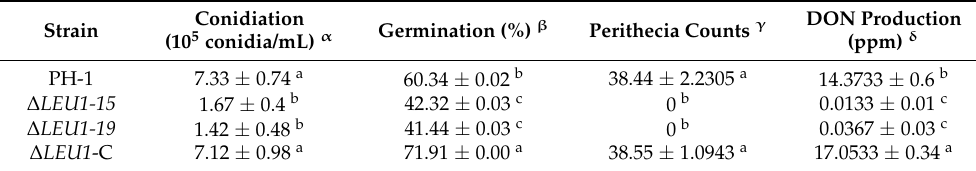
Table 1. Conidiation, conidial germination perithecia counts, and DON production in the PH-1, Δ LEU1, and Δ LEU1 -C strains.